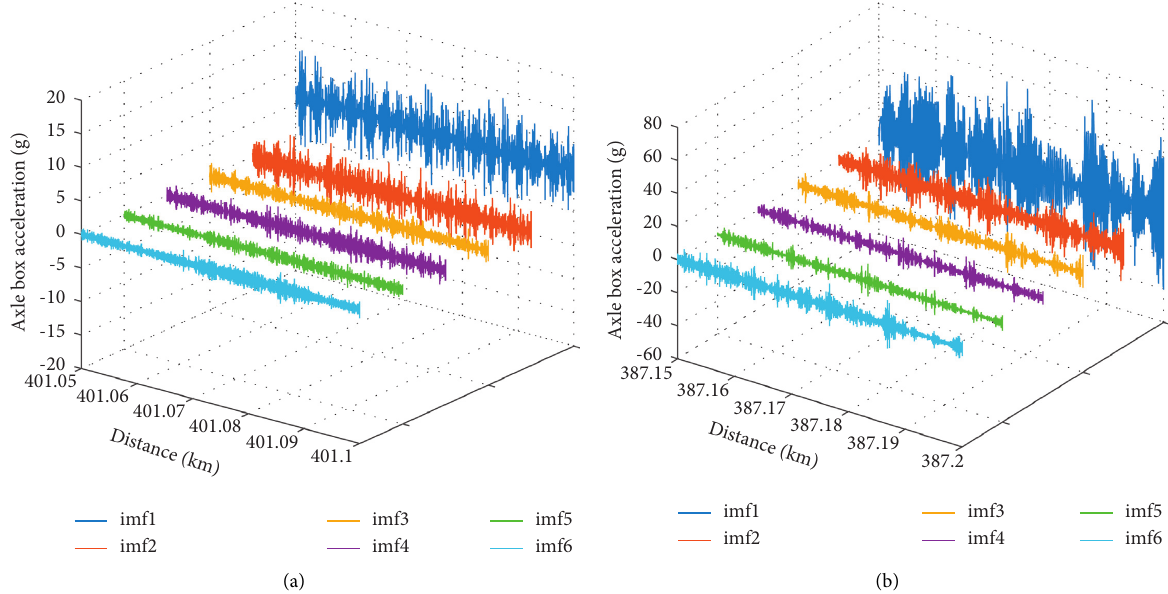
Figure 7: The plots of the decomposed subsignals of the acceleration signal for (a) the normal rail sections and (b) the corrugation rail section.